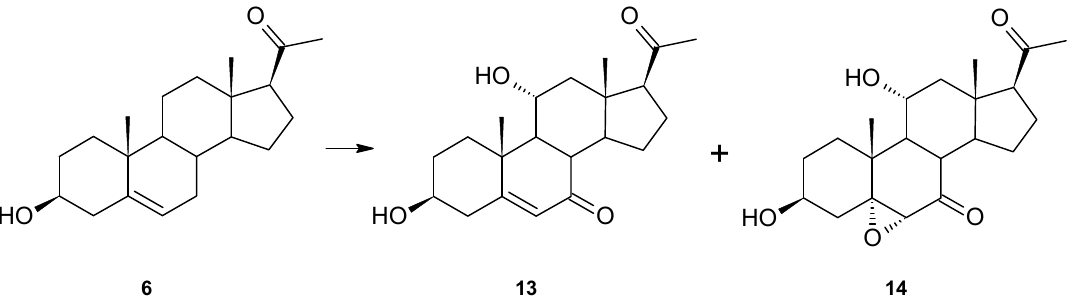
Figure 5. Pregnenolone ( 6 ) modification by Isaria farinosa KCh KW1.1 strain.